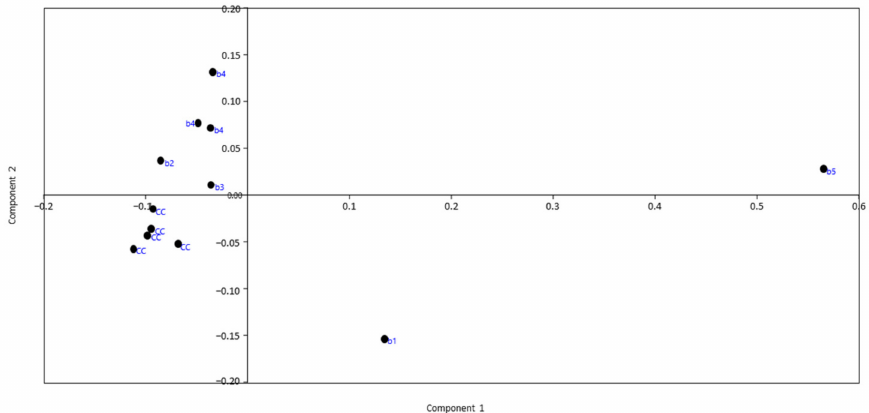
Figure 3. The score scatter plot (PC1 vs PC2) of the Principal Component Analysis (PCA) model constructed by employing the PAST free software for the calibration curve points (CC) and the CMS batches b1, b2, b3, b4 and b5. The data were the area ratios of the 23 chromatographic peaks divided by the